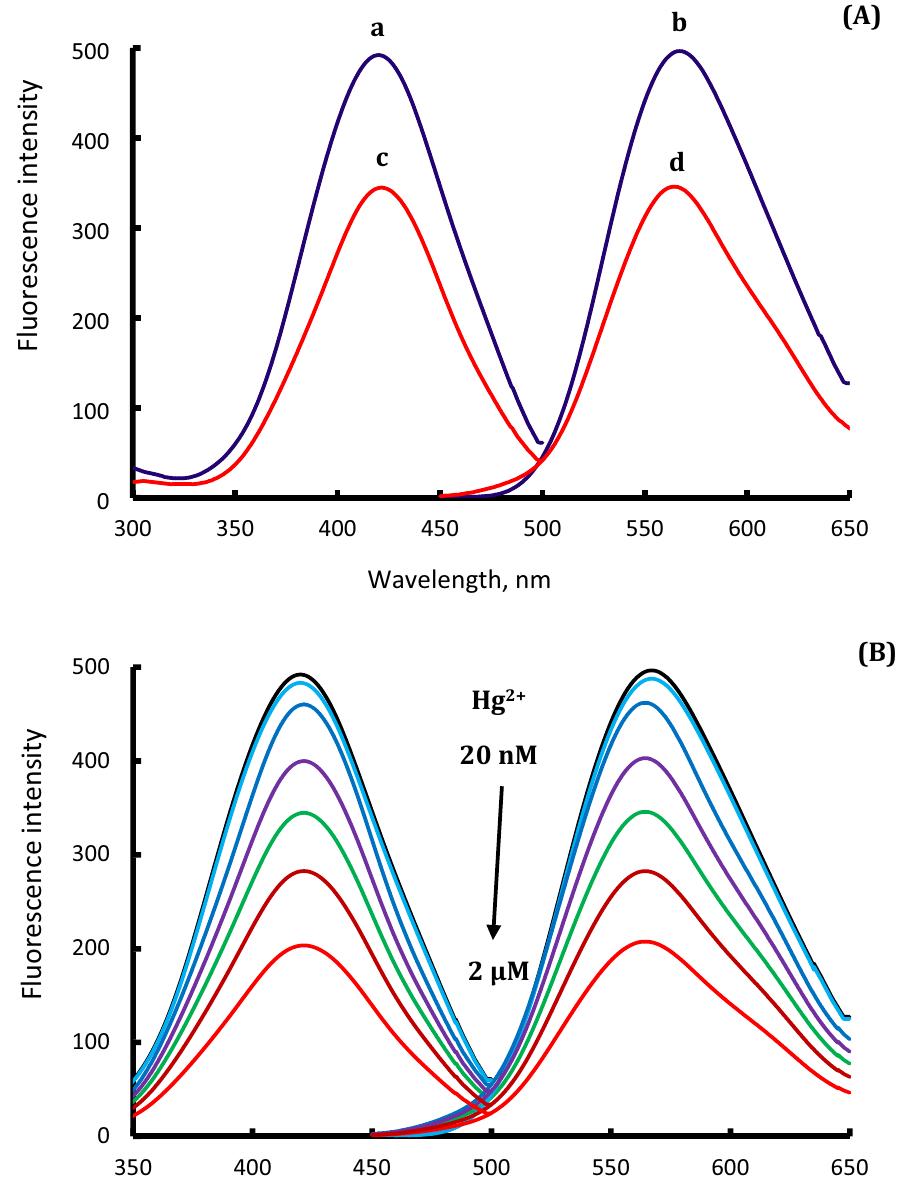
Figure 3. ( A ) for fluorescence (excitation and emission) spectra of OPD/H 2 O 2 /PVP-Ag-NPs system (a, b, respectively) and after their quenching by 1.0 µM of Hg 2+ (c, d), while ( B ) for fluorescence spectra of OPD/ H 2 O 2 /PVP-Ag-NPs system in the presence of various concentrations of Hg 2+